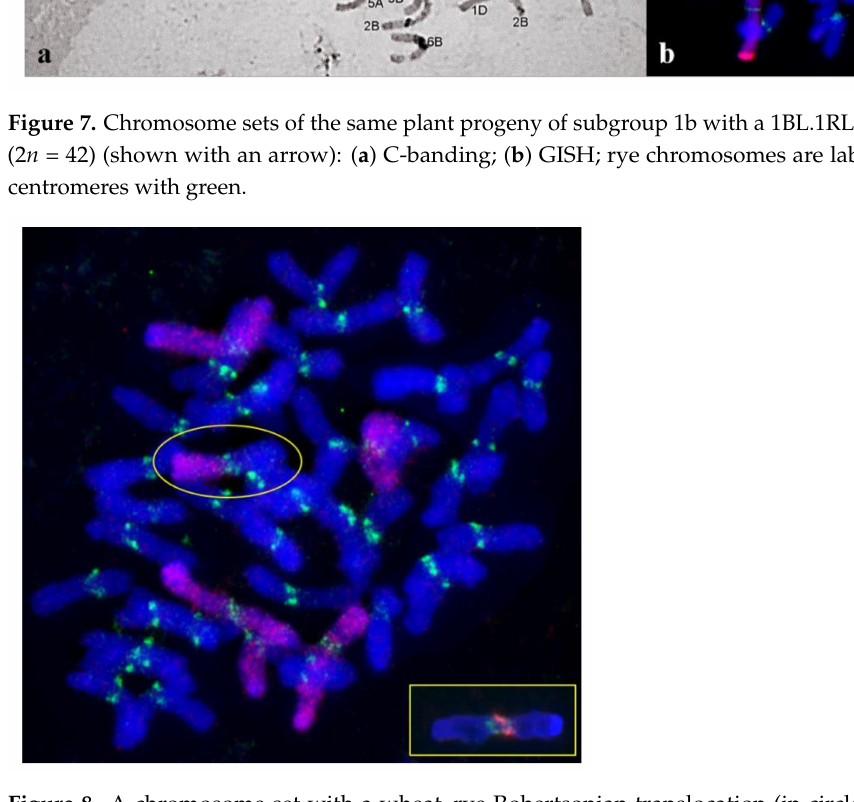
Figure 8. A chromosome set with a wheat–rye Robertsonian translocation (in circle). GISH, rye chromosomes are labeled red and pAet6-09, green. The inset shows the chromosome centromere with two non-overlapping probes pAet6-09 (green) and pAWRc